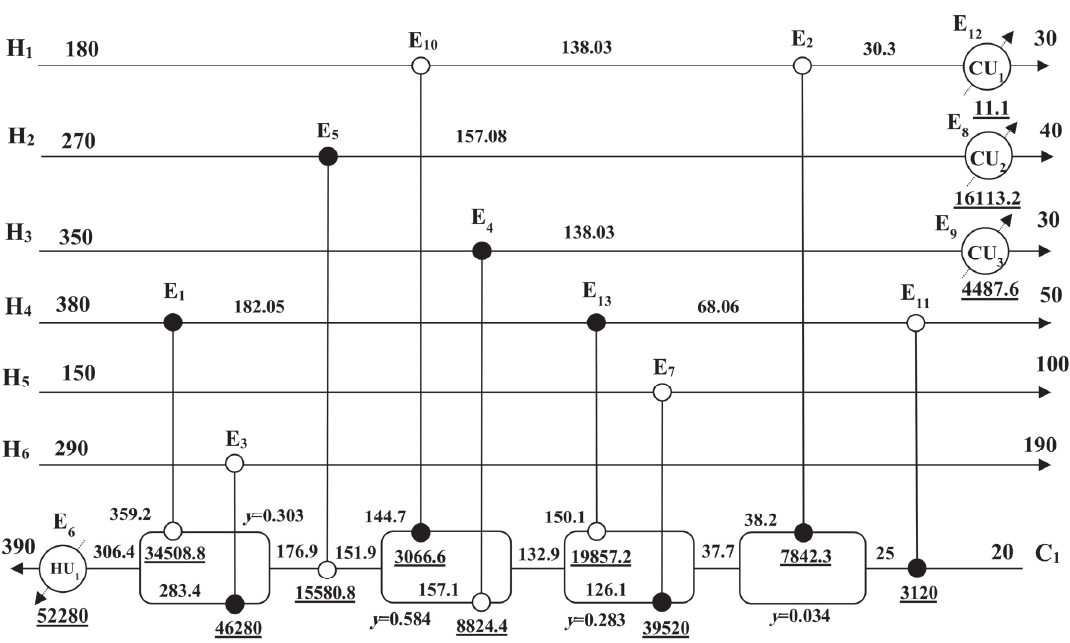
Fig. 9 – Optimum HEN obtained for the second case study with ΔT